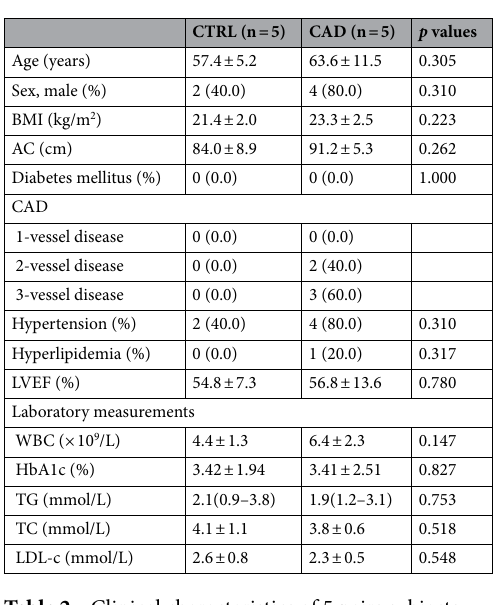
Table 2. Clinical characteristics of 5 pairs subjects.